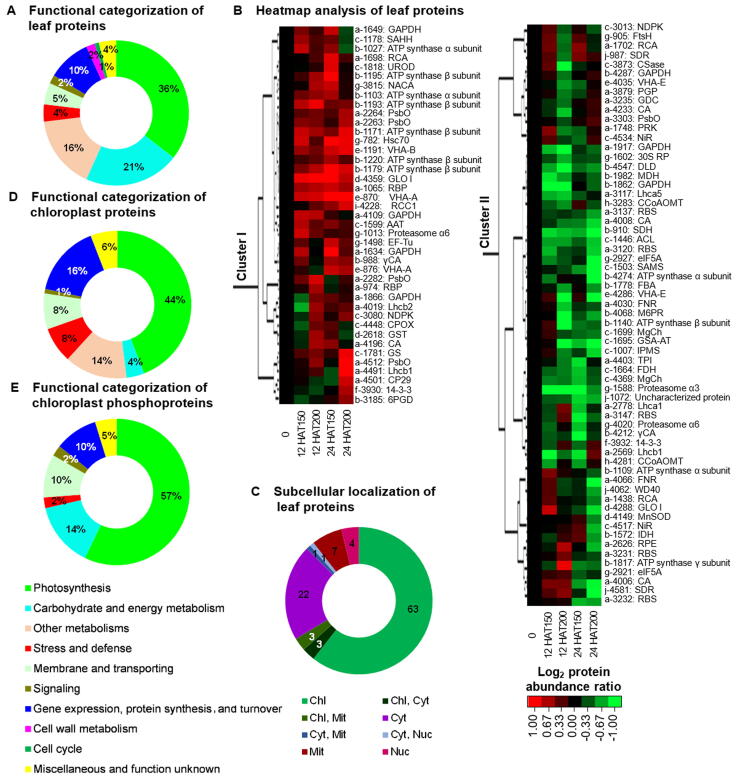
Functional categorization, hierarchical clustering analysis, and subcellular location prediction of the Na2CO3-responsive proteinsA. Functional categories of 104 Na2CO3-responsive leaf protein species according to functional domains analyzed by BLAST programs. The percentages of proteins species in different functional categories are shown in the pie. B. Heatmap of Na2CO3-responsive protein species from leaf proteome. Two main clusters (I and II) are shown in the figure, functional categories indicated by lower-case letters (a, photosynthesis; b, carbohydrate and energy metabolism; c, other metabolisms; d, stress and defense; e, membrane and transporting; f, signaling; g, protein synthesis and turnover; h, cell wall metabolism; i, cell cycle; j, miscellaneous and function unknown), spot numbers and protein name abbreviations are listed on the right side (detailed information on protein names and abbreviations can be found in Table S1); The scale bar indicates log (base 2) transformed protein abundance ratios ranging from −1.0 to 1.0. The increased and decreased proteins are represented in red and green, respectively. The color intensity increases with increasing abundant differences. C. Predicted localization of proteins from leaf proteome using online tools: YLoc (http://abi.inf.uni-tuebingen.de/Services/YLoc/webloc.cgi), LocTree3 (https://rostlab.org/services/loctree3/), Plant-mPLoc (http://www.csbio.sjtu.edu.cn/bioinf/plant-multi/), ngLOC (http://genome.unmc.edu/ngLOC/index.html), and ChloroP (http://www.cbs.dtu.dk/services/ChloroP/). The numbers of protein species with different locations are shown in the pie. Chl, chloroplast; Cyt, cytoplasm; Mit, mitochondria; Nuc, nucleus. D. Functional categories of 102 Na2CO3-responsive protein species in chloroplasts. E. Functional categories of 84 Na2CO3-responsive phosphoprotein species in chloroplasts. The percentages of protein species in different functional categories are shown in the pie charts.